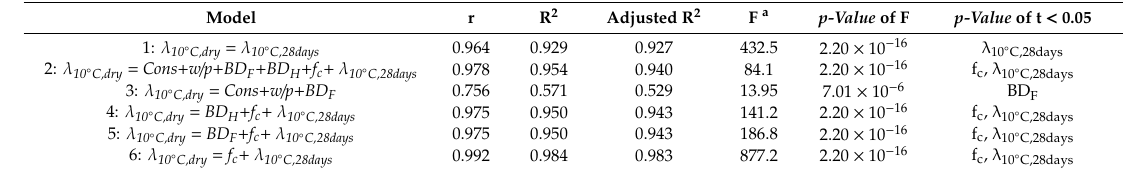
Table 11. Tested regression models and their main